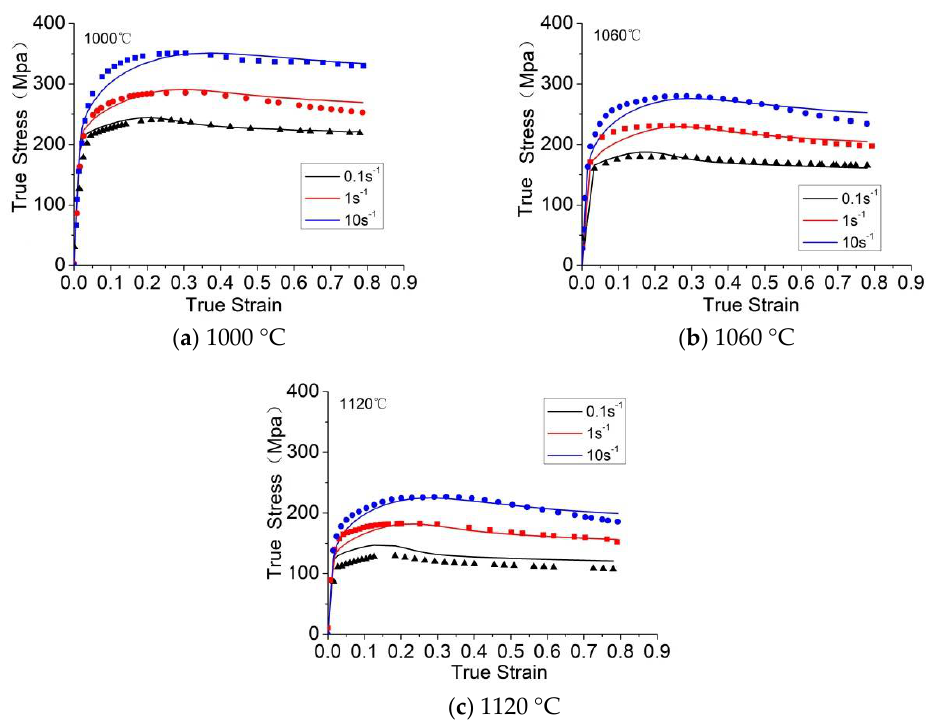
Figure 9. Comparison of the stress model prediction (lines) and experimental (points) values. Reproduced with permission from [24]. Copyright Elsevier, 2017.